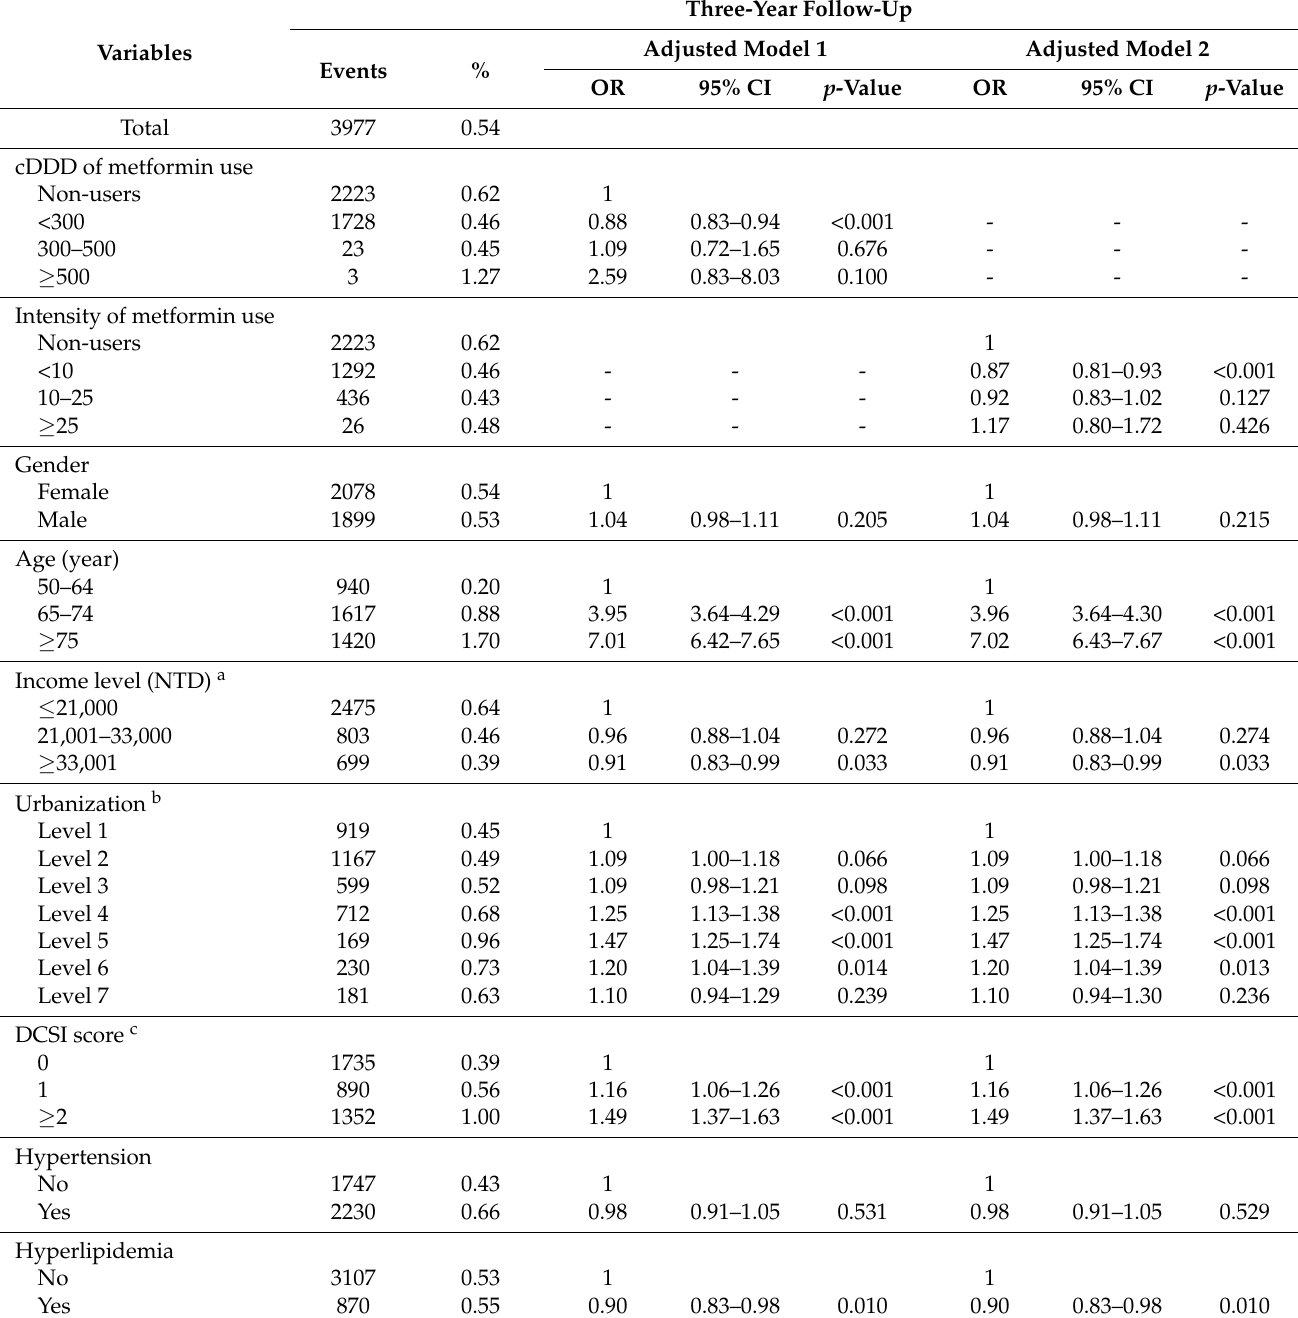
Table 2. Three-year follow-up of incident Parkinson’s disease in new-onset diabetes mellitus patients with metformin